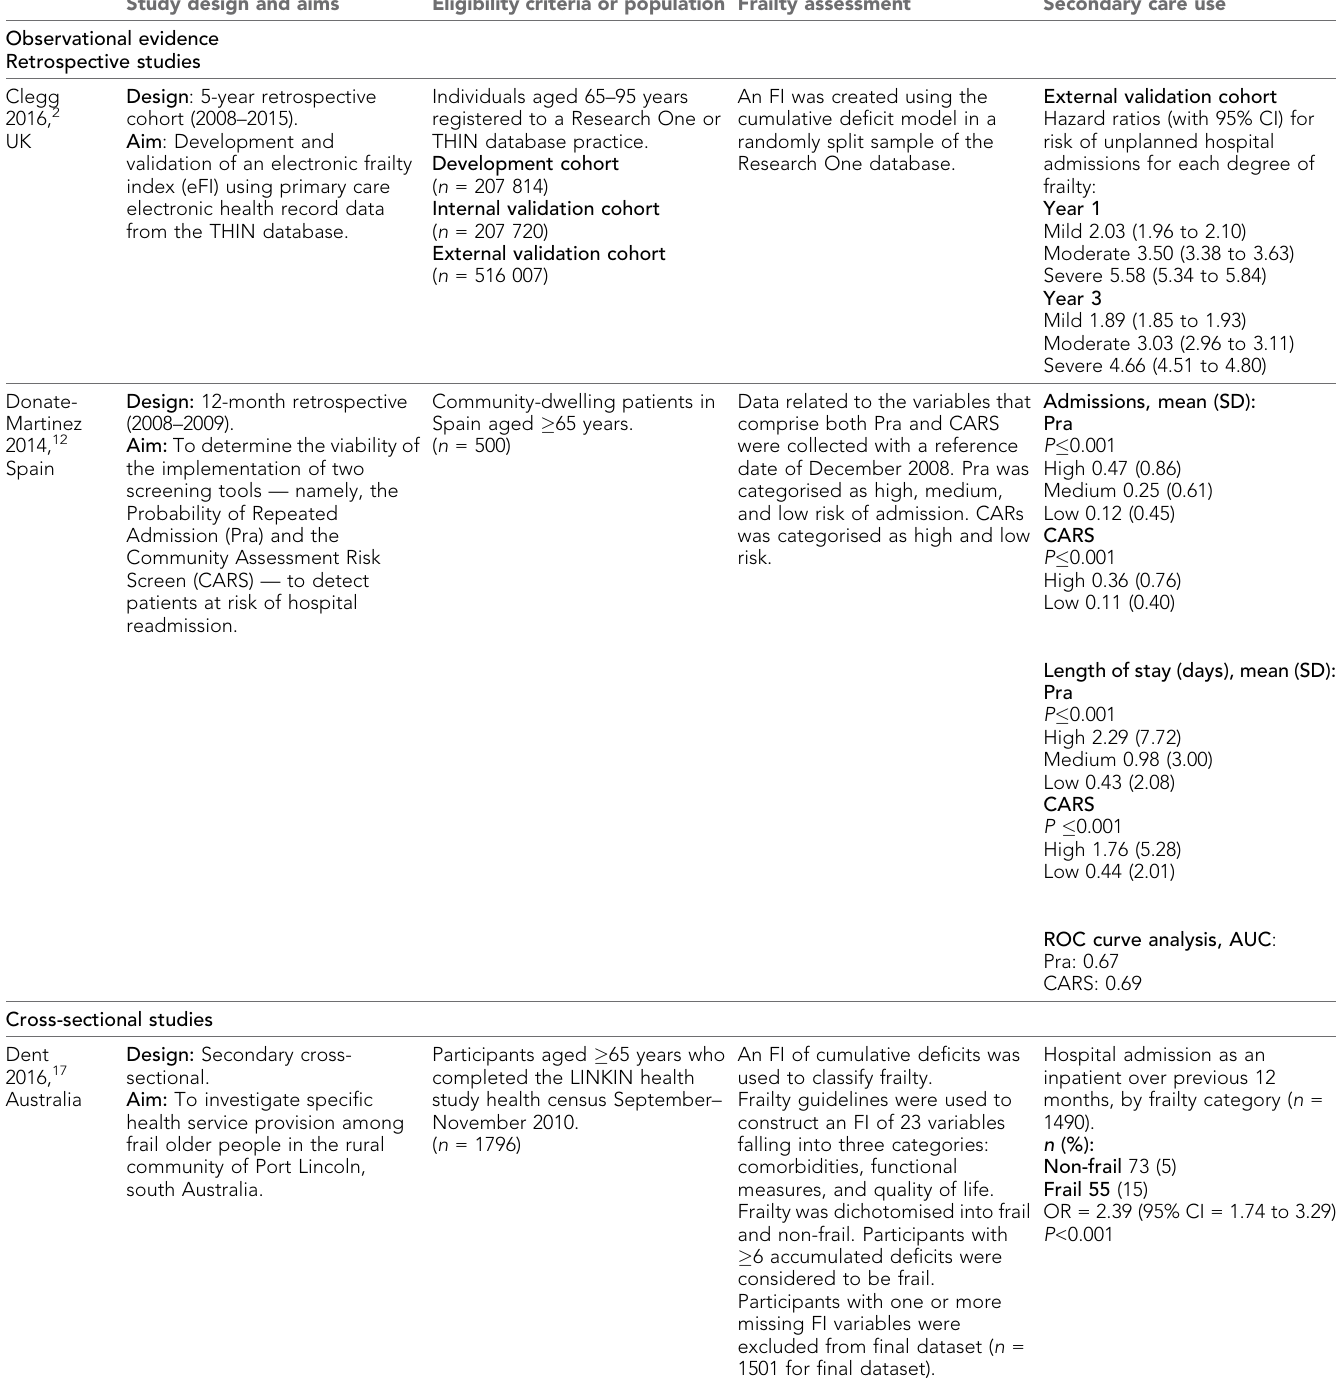
Table 1. Summary of evidence for included